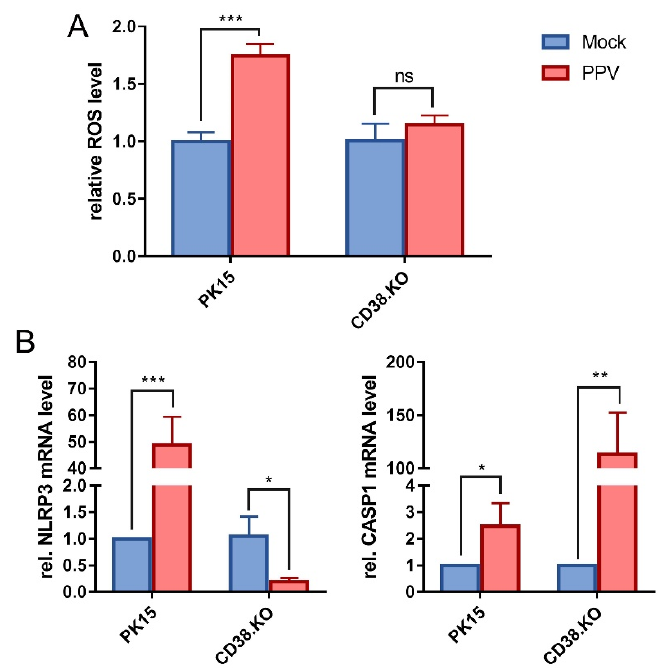
Figure 3. Loss of CD38 function inhibited ROS/NLRP3/CASP1 pathway activated by PPV. ( A ) The DCFH-DA probe was loaded into the cells infected with PPV (MOI = 1, 24 hpi). Fluorescence signals at 488 nm excitation and 525 nm emission wavelength were collected, and the relative level of intracellular ROS was calculated and is shown as fold change by normalizing to the mock-infected cells. ( B ) Quantitative real-time RT-PCR was used to detect the relative mRNA levels of NLRP3